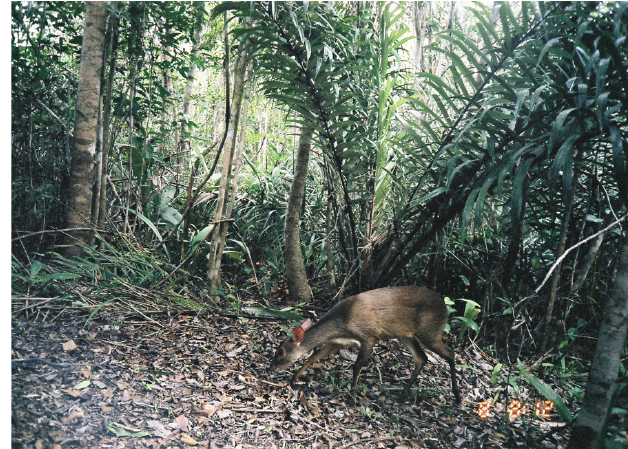
Figure 7. A young brown brocket deer ( ) registered in the